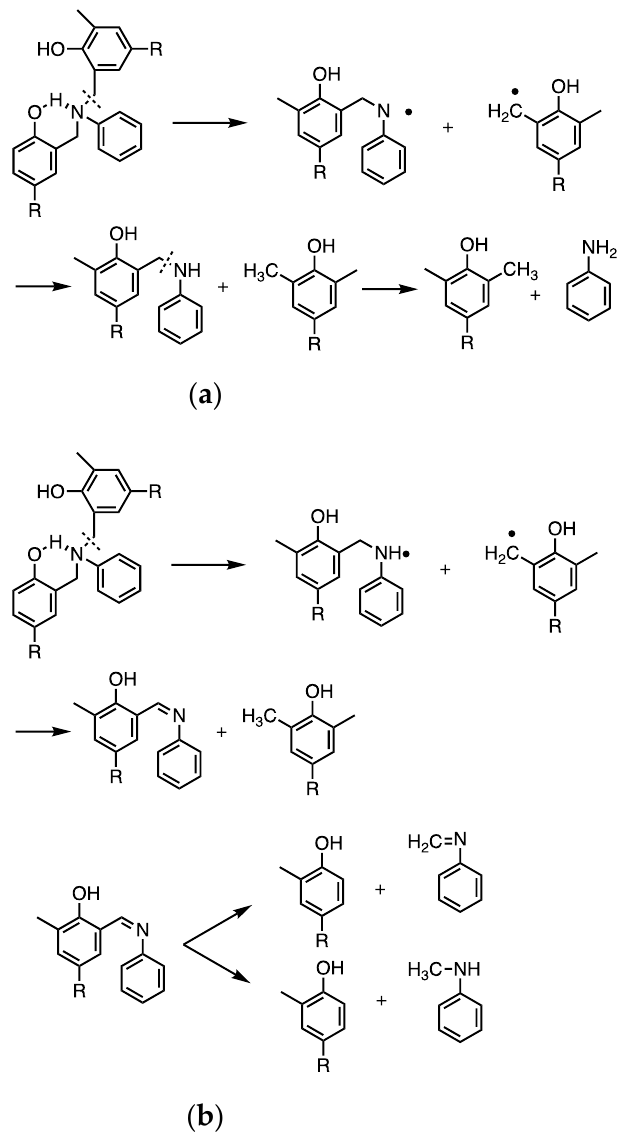
Figure 5. Degradation of hydrogen bonded nitrogen in the Mannich base of aniline-based benzoxazines to produce ( a ) aniline or ( b ) conjugated Schiff bases [45].